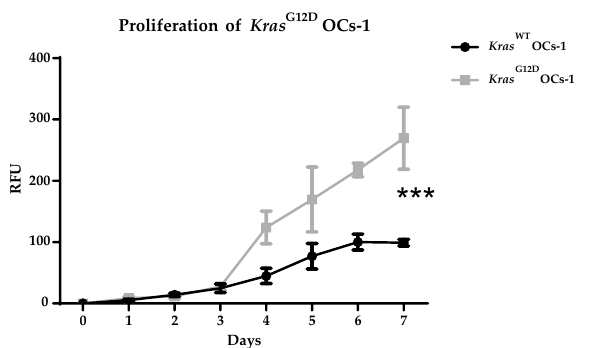
Figure 5. Alamar Blue assay for the proliferation of Kras WT OCs-1 and Kras G12D OCs-1. Mean and SD of three replicates of Kras WT OCs-1 and Kras G12D OCs-1. Relative fluorescence units (RFU). Student’s t -test *** p -value = 0.0003, (α =